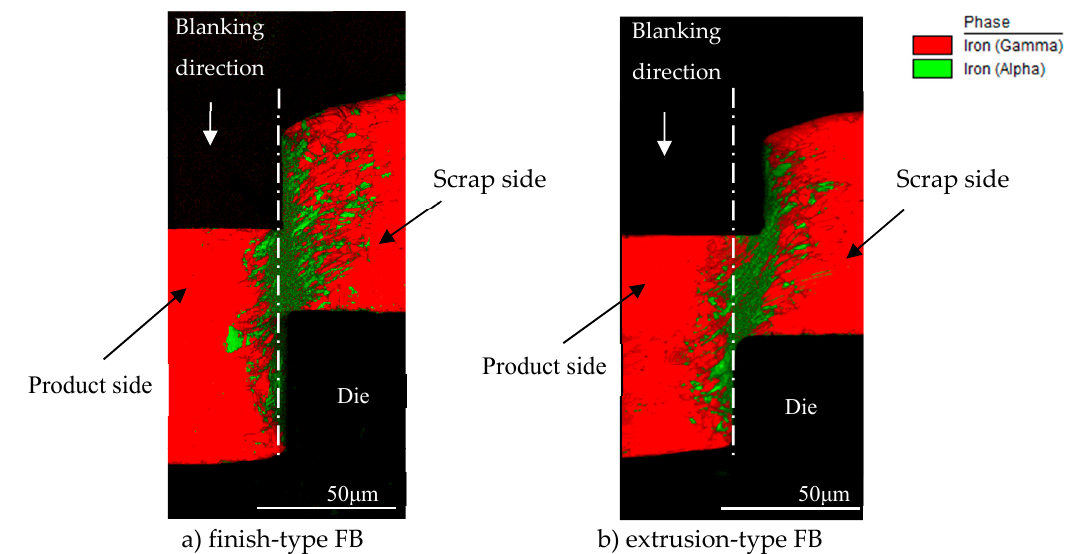
Figure 9. Comparison of kernel average misorientation (KAM) map for 60% t punch penetration between finish-type FB and extrusion-type FB: ( a ) finish-type FB; ( b ) extrusion- type FB.